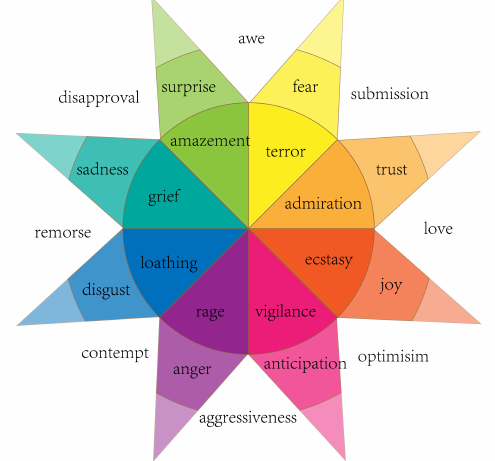
Figure 1. Color wheel model proposed by